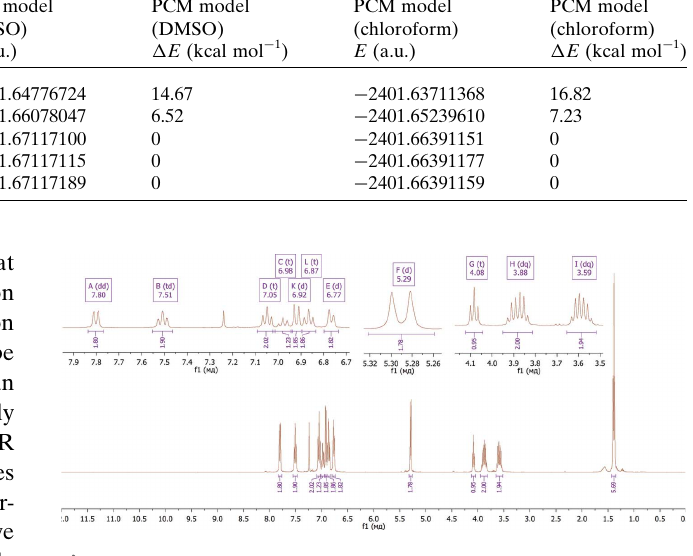
Figure 4 1 H NMR spectrum of 7 in CDCl